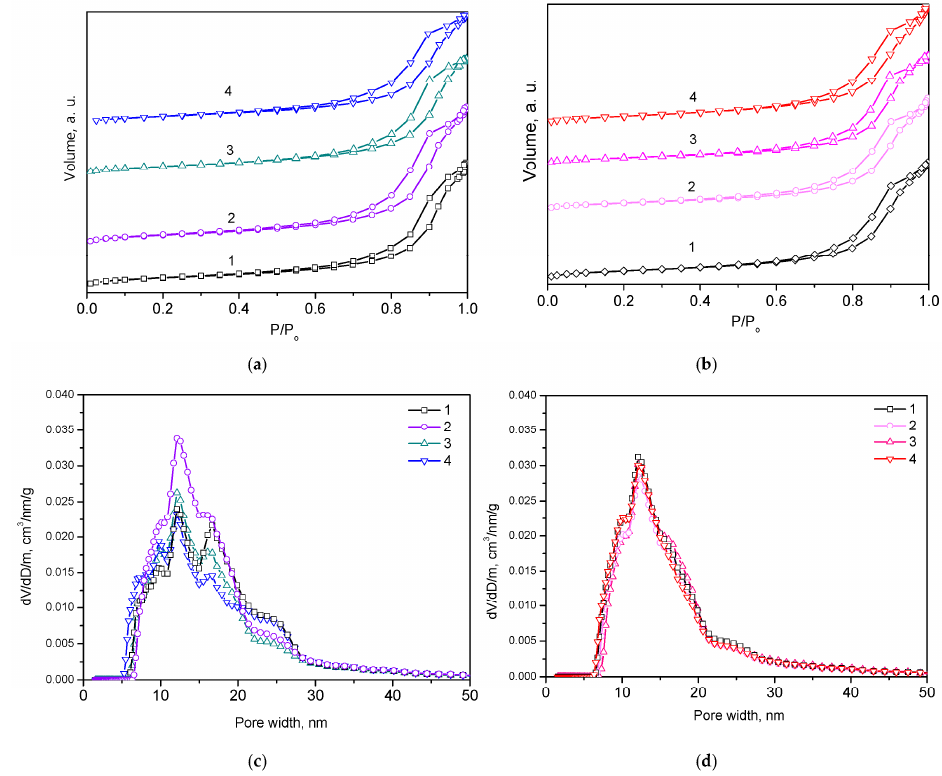
Figure 8. N 2 adsorption–desorption curves ( a , b ) and distribution of pore size ( c , d ) for catalysts after reaction. ( a , c ) 10Ni/Al 2 O 3 -CI (1), 5Ce 0.2 Ni 0.8 O 1.2 /Al 2 O 3 -CI (2), 10Ce 0.2 Ni 0.8 O 1.2 /Al 2 O 3 -CI (3), and 20Ce 0.2 Ni 0.8 O 1.2 /Al 2 O 3 -CI (4). ( b , d ) 10Ni/Al 2 O 3 -SG (1), 20Ce 0.8 Ni 0.2 O 1.8 /Al 2 O 3 -SG (2), 20Ce 0.5 Ni 0.5 O 1.5 /Al 2 O 3 -SG (3), and 20Ce 0.2 Ni 0.8 O 1.2 /Al 2 O 3 -SG (4). For Ce 1−x Ni x O 2−x /Al 2 O 3 catalysts after the reaction, the phase of the initial support (alumina) is retained (Table 3, Figure 9). However, for samples without cerium or with a low content of it (< 3.0 wt.%), an increase in the formal unit cell parameter of alumina is noted (Tables 2 and 3). This may point to the formation of a solid solution based on the Al 2 O 3 spinel structure. The Ce-containing phase is observed only in samples with a high cerium content (6–15 wt.%), except for the 20Ce 0.2 Ni 0.8 O 1.2 /Al 2 O 3 -SG sample. Its type de- pends on the method of catalyst synthesis. In the case of the CI-series, the CeAlO 3 phase is formed, while in the case of the SG-series, the CeO 2 phase is formed. In samples for which the Ce-containing phase was not detected by XRD, its presence in a highly dis- persed form, in the form of CeO 2 or CeAlO 3 , cannot be ruled out. A similar trend is also found for the Ni-containing phase, which is clearly observed in the form of metallic Ni ° only in samples with a nickel content of 10 wt %. The average crystallite size of the nickel phase is large and is ~6 nm, except for the Ni/Al 2 O 3 -CI sample with an average particle size of ~9 nm. The obtained particle size of the active component is favorable in terms of resistance to coking. According to [59], the maximum rate of carbonaceous deposits is achieved at a nickel particle size of 20–40 nm.